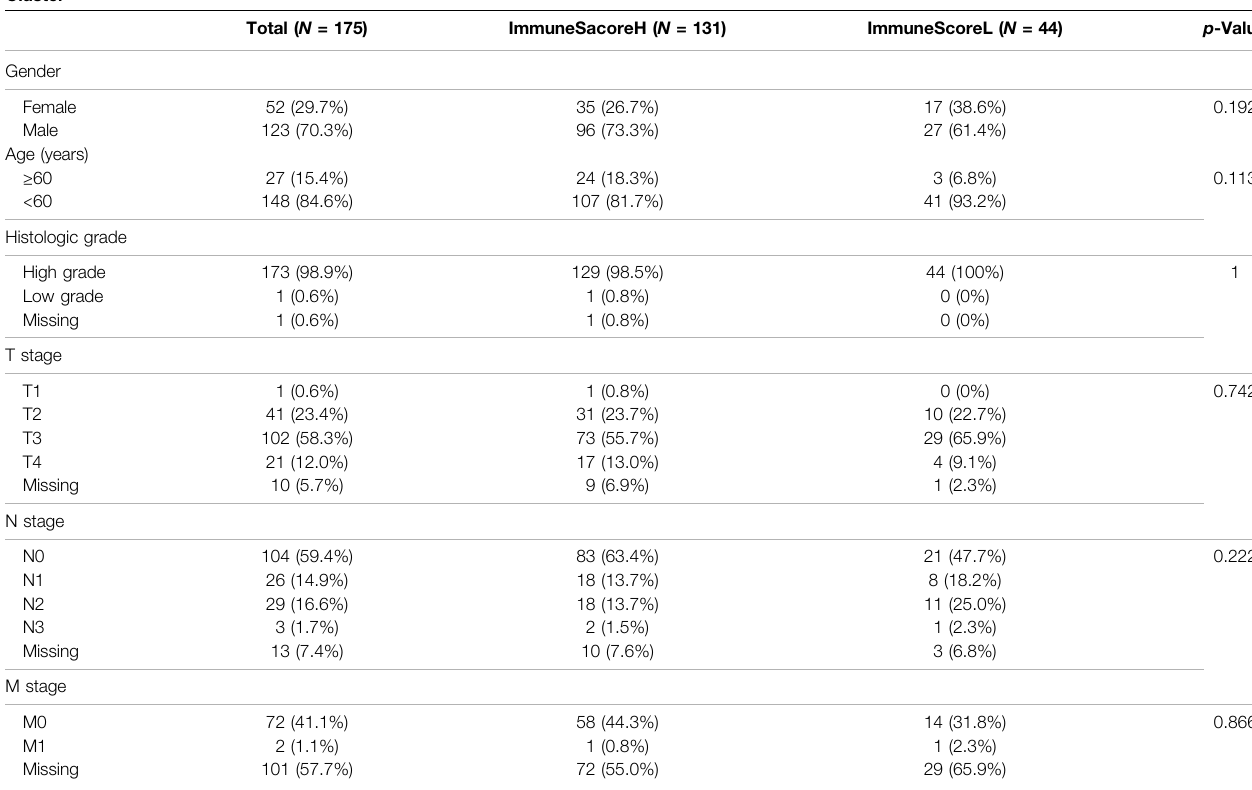
TABLE 1 | The Clinicopathologic characteristics of the immune score